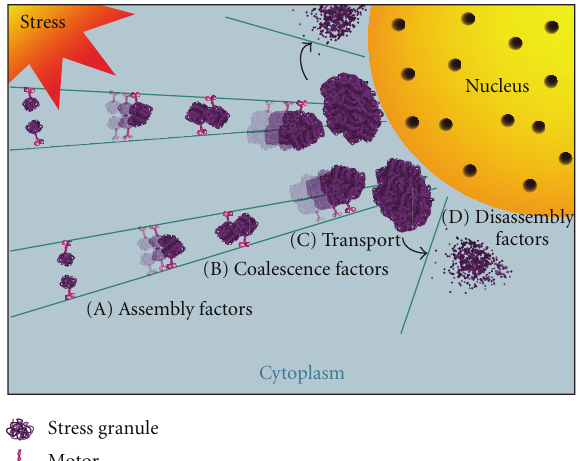
Figure 1: Model of microtubules and molecular motors in stress granule dynamics. When cells are exposed to stress-induced trans- lational inhibition, SGs begin to form as small foci (A), assisted by assembly factors, and are transported along microtubules by molecular motors, enabling coalescence of SGs into larger foci (B). This process of coalescence continues while SGs are transported along microtubules to the perinuclear region where larger granules reside (C). Once the stress is removed SGs disassemble (D) aided by molecular motors as well as other disassembly factors. See Table 1 for the list of cytoskeletal proteins that function in these